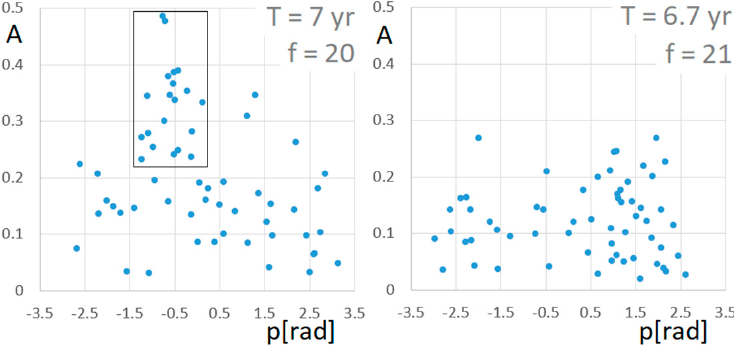
Figure 4. Data from Figures 2 and 3 for two given frequencies (periods); the left is for a frequency that seemed to be “significant” and the next a frequency which simply seems to represent the noise alone—the random distribution of phase. For f = 20, the group of stations with high amplitudes and within the narrow span of phases is indicated by the box. It is to be checked to see if the group is also a group on the map.